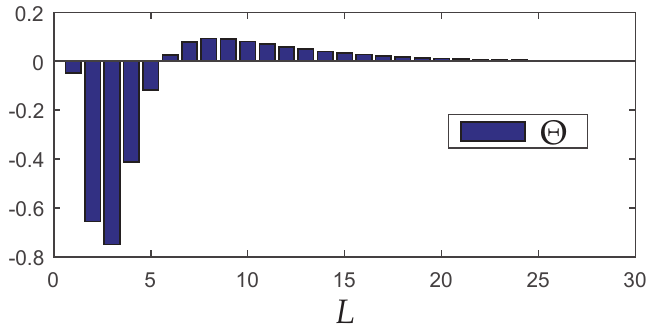
Figure 7. Performance measurement index Θ in terms of a fixed L for the network under investigation.